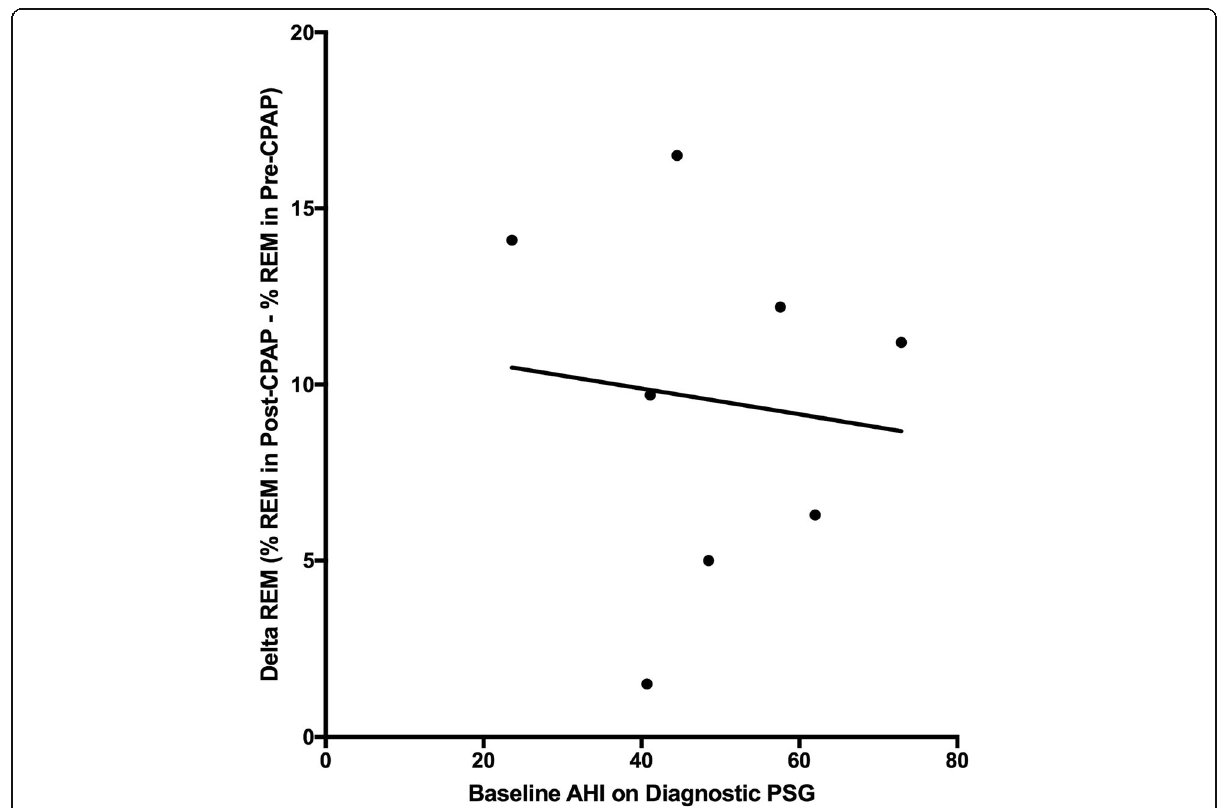
Fig. 4 Correlation between AHI on baseline PSG and amount of REM rebound (Delta REM) on CPAP